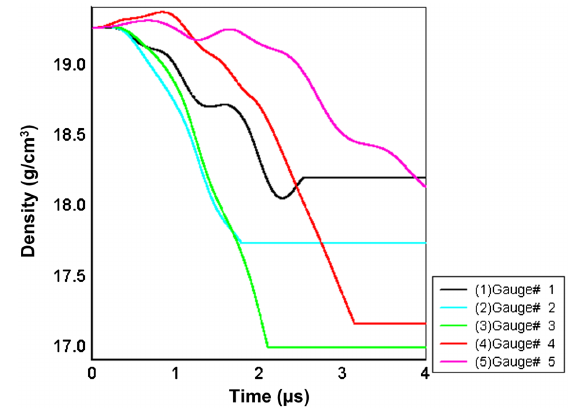
FIG. 16. Density profiles over time for Test 3 at five different gauges placed at the most loaded longitudinal section. The gauge locations are the same as indicated on the schematic diagram in Fig.